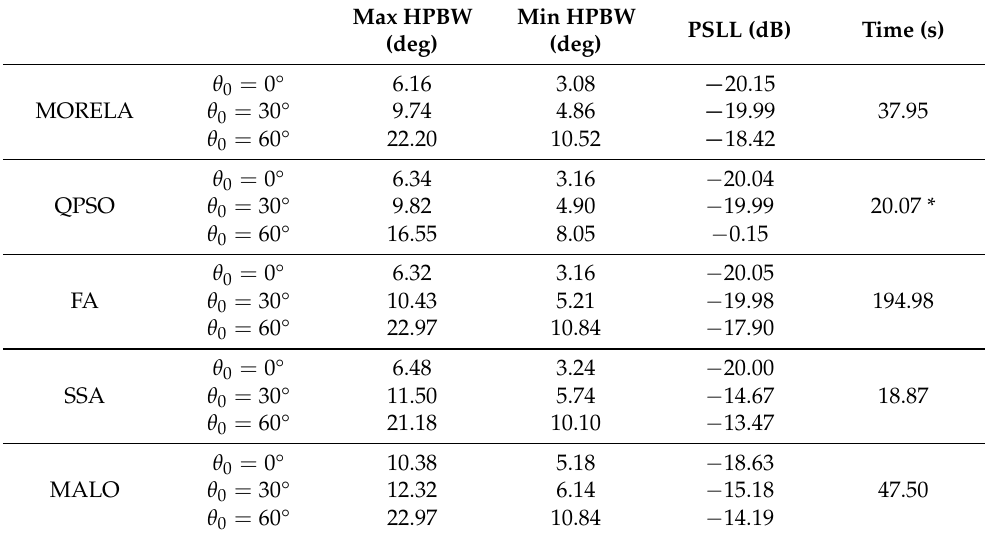
Table 3. Performance comparison for symmetric NUSLA.